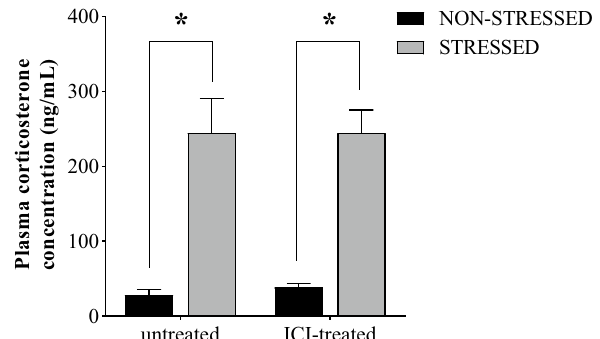
Figure 1. Plasma concentration of corticosterone in untreated non-stressed control rats, untreated rats submitted to stress, non-stressed rats treated with ICI118,551, and rats both treated with ICI118,551 and submitted to stress. The bars indicate mean ± S.E.M. of 6 rats/group. *p ≤ 0.05 compared to control, two-way ANOVA plus Tukey